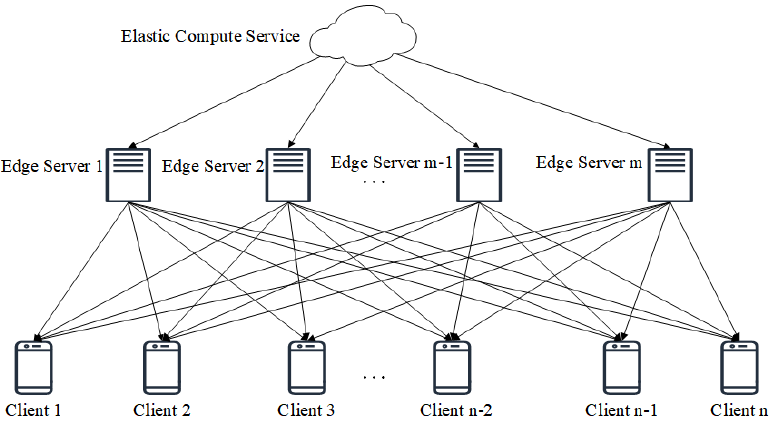
Figure 1. The framework of edge computing.